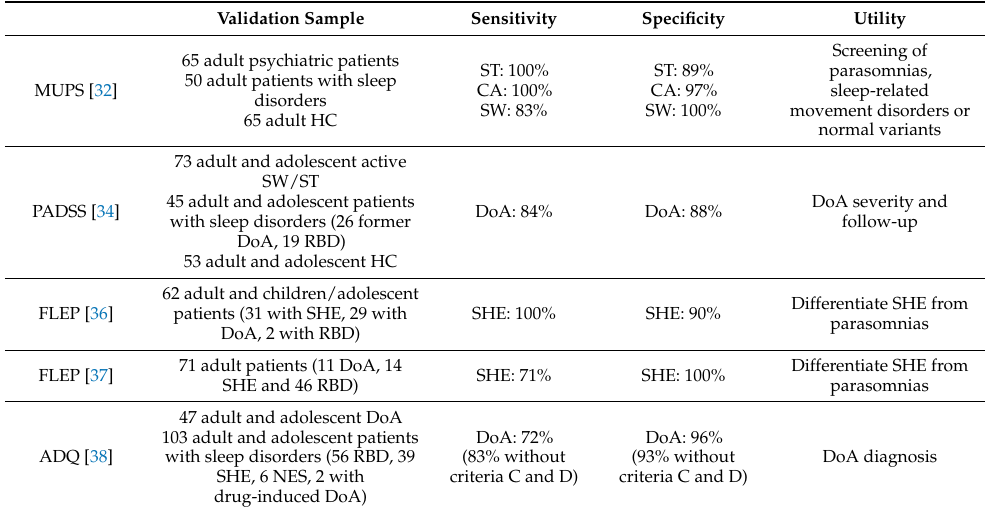
Table 3. Scales available for NREM sleep parasomnias screening, diagnosis, or follow-up. Validation